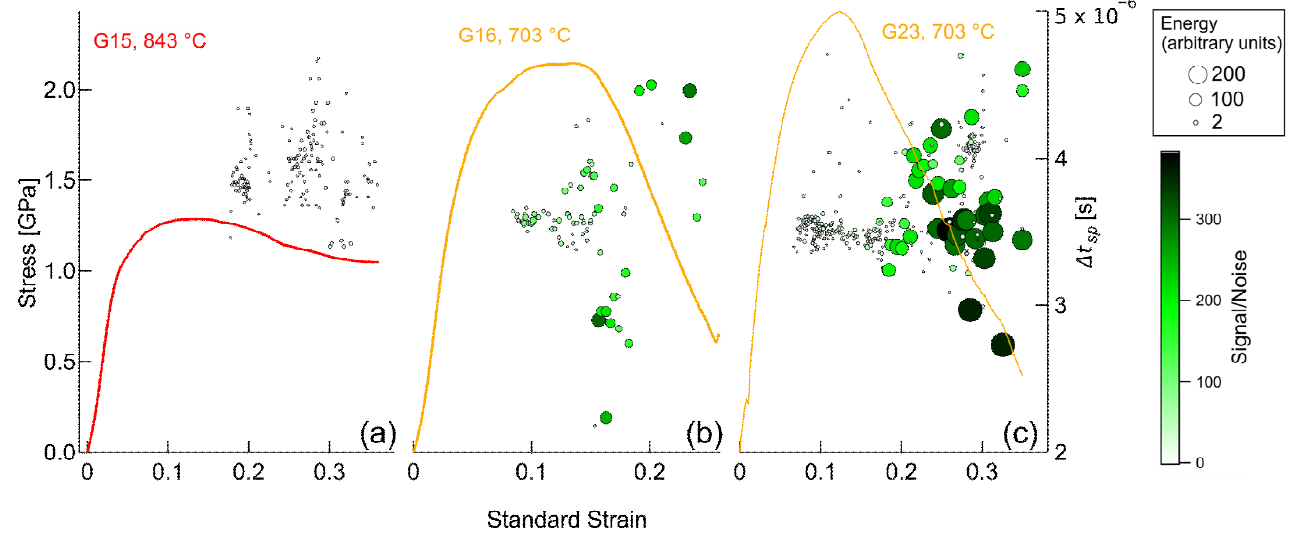
Figure 14. P- and s-wave arrival time differences of AEs and stress-strain curves for experiments G15 ( a ), G16, ( b ) and G23 ( c ). AEs are visualized here using signal–noise ratio, which is a proxy for their radiated energy. Stress-strain curves are the same as those introduced in Figure 4.